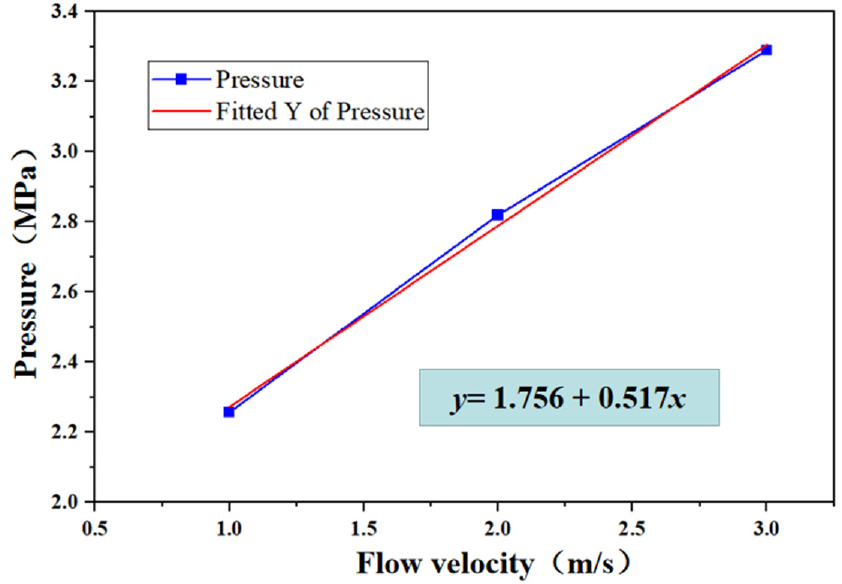
Figure 13. Relationship between maximum pressure of plugging agent and crude oil flow velocity and mathematical model.